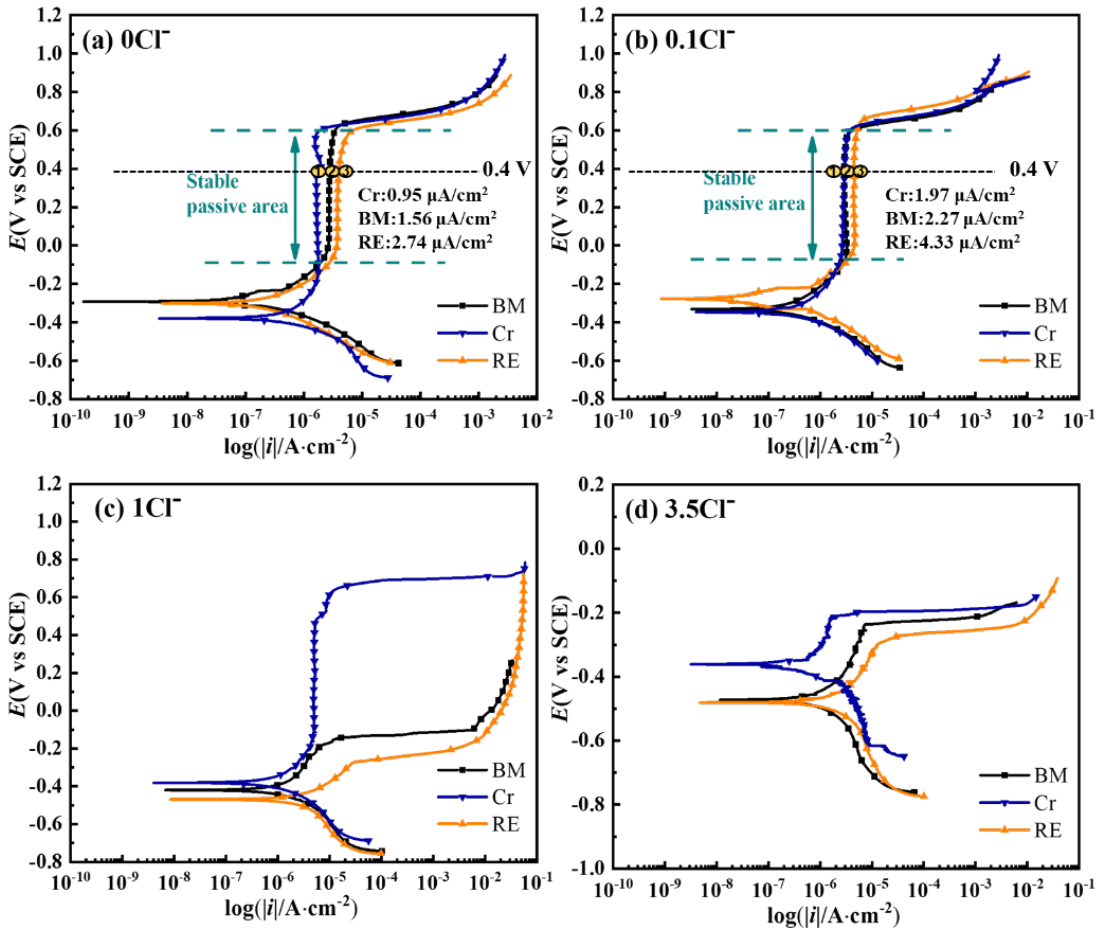
Figure 6. Cyclic potentiodynamic polarization curves of three steel rebars applied in different Cl − -containing solutions: ( a ) blank samples, ( b ) 0.1Cl − , ( c ) 1Cl − , and ( d )3.5 Cl − (unit: wt.%).